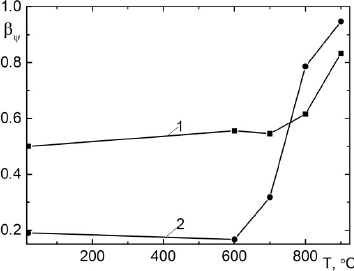
Figure 6. Temperature dependence of the coefficient of influence of hydrogen at a pressure of 30 MPa on the reduction of area β ψ of samples from alloys CM-88Y (1) and ZhS3DK (2). High-cycle fatigue (HCF) is an important characteristic of the performance of rotating parts of power equipment, such as rotors, discs and blades of turbines and engines [46–